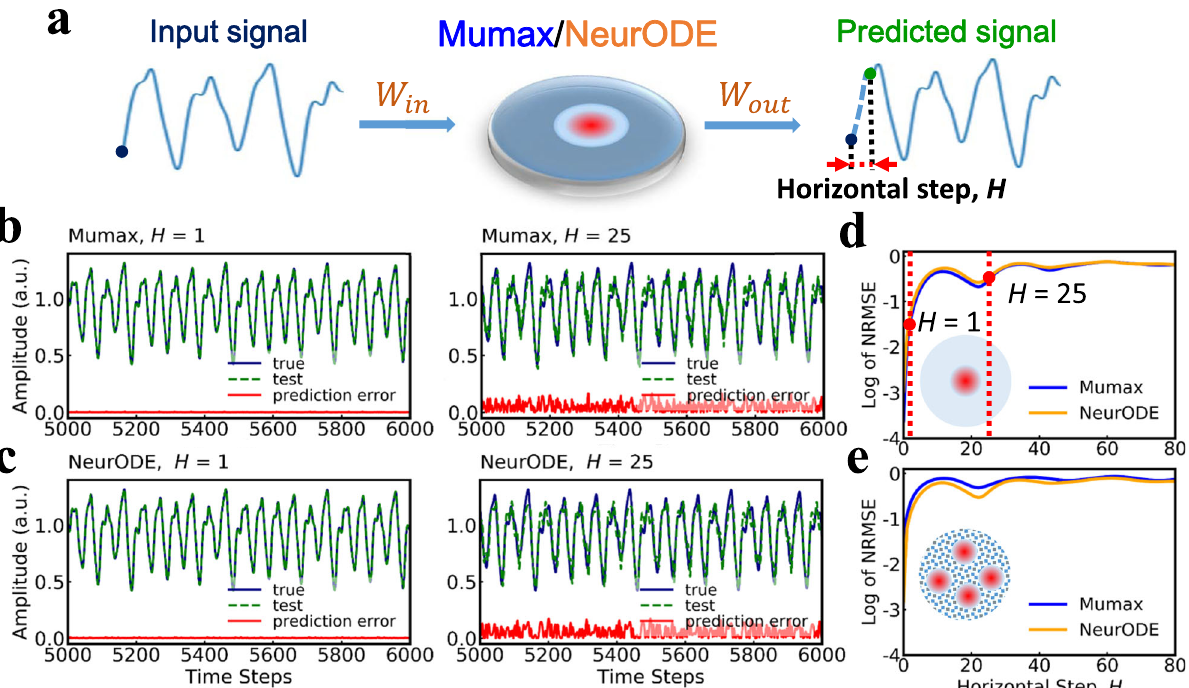
Fig. 3 Modeling of a sophisticated spintronic task, Mackey-Glass time series prediction with skyrmion systems, using Neural ODEs. a Schematic graph of the procedure for doing the prediction task. The purpose is to predict the Mackey-Glass time series at a future time. The input signal, preprocessed through a read-in matrix W in , is fed into the reservoir, which is a skyrmion system modeled by the trained Neural ODE or micromagnetic simulations. A trained output matrix W out is used for reading out the reservoir states and providing the predicted signal. b , c Selected testing (green dashed) results for prediction horizontal step H = 1 (for short-term prediction) and H = 25 (for long-term prediction), predicted by the one-skyrmion system modeled by micromagnetic simulations in b and the Neural ODE in c , in comparison with the true trajectory (blue) of Mackey-Glass time series. The red curves show the prediction error compared to the true trajectory. d , e Normalized root mean square error (NRMSE) as a function of prediction horizontal step H , in log scale, for the testing set by using the trained Neural ODE (orange) and micromagnetic simulations (blue) for the one-skyrmion system in d and the multi-skyrmions system in e